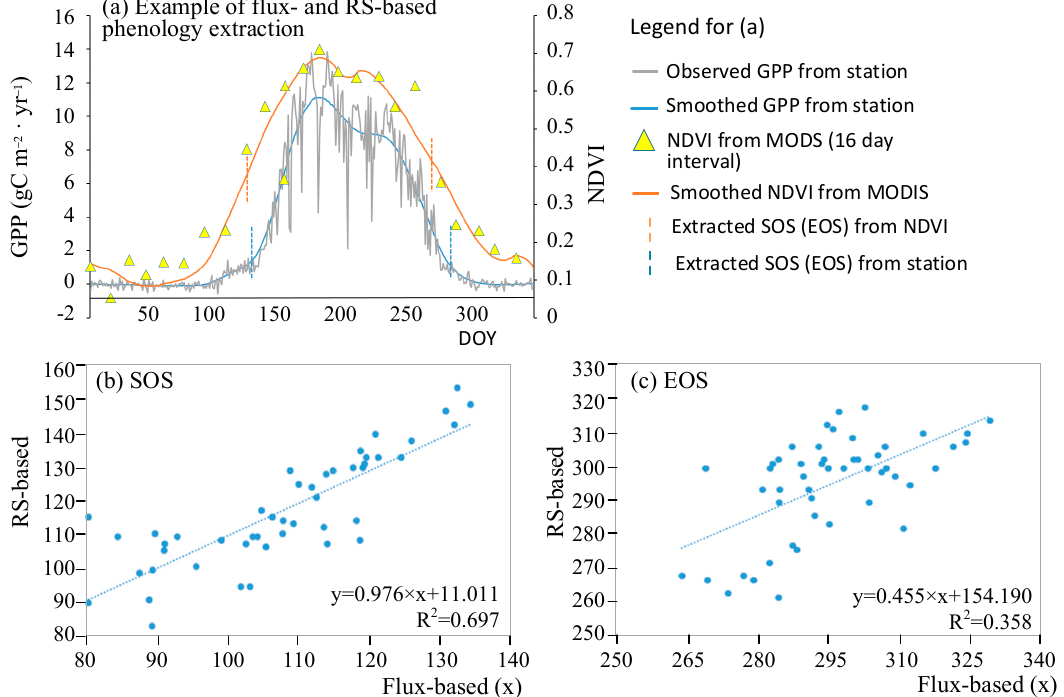
Figure 2. Comparison of the dates of the phenological events (SOS and EOS) extracted from remote sensing imagery (RS-based) and from the flux stations (flux-based). The flux-based and RS-based events are exampled (for site-id US-UMB) in ( a ) and each point in ( b , c ) denotes the SOS (or EOS) in day of year (DOY) from the RS-based and flux-based methods for an identical location and year. The mean and standard deviation (std) of the phenological events including SOS, EOS, and GL in the North American forests from 2001 to 2020 are presented in Figure 3.